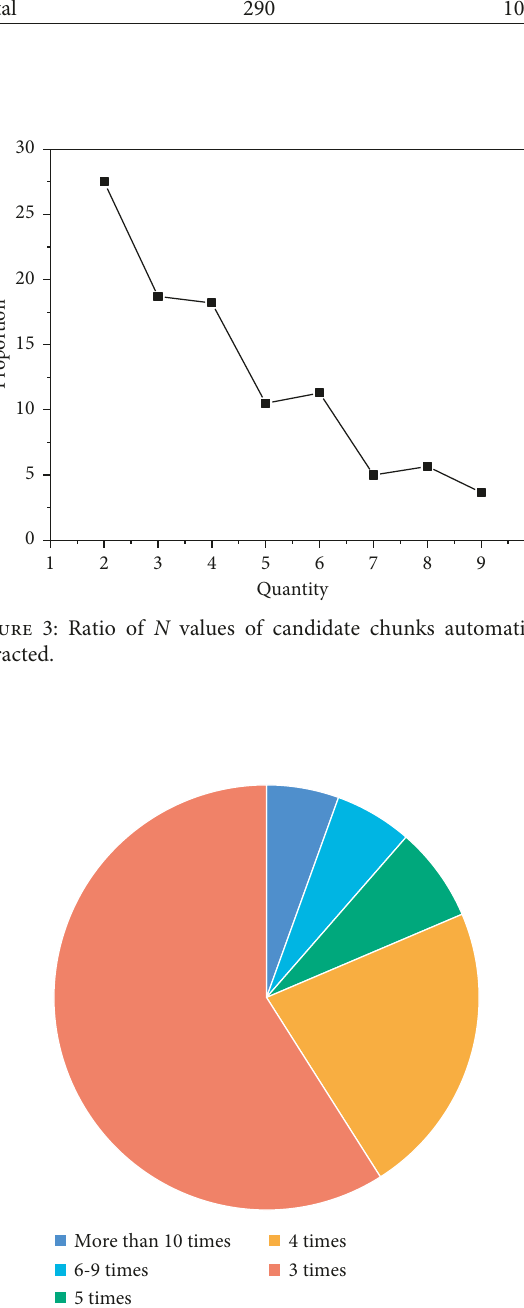
Figure 4: Frequency ratio of candidate chunks automatically extracted.